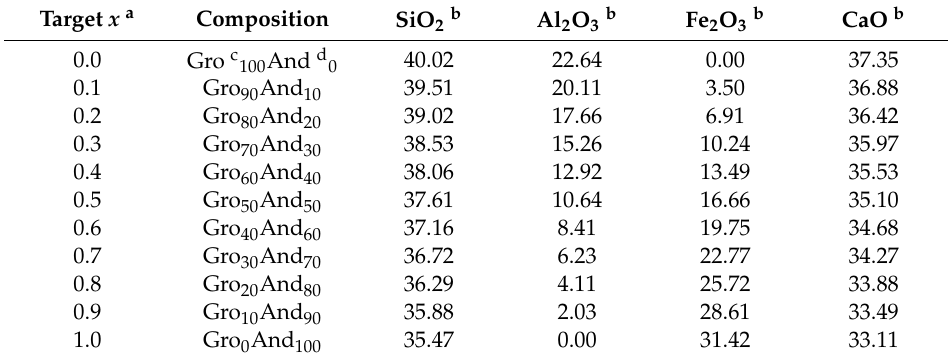
Table 1. Starting compositions used in this